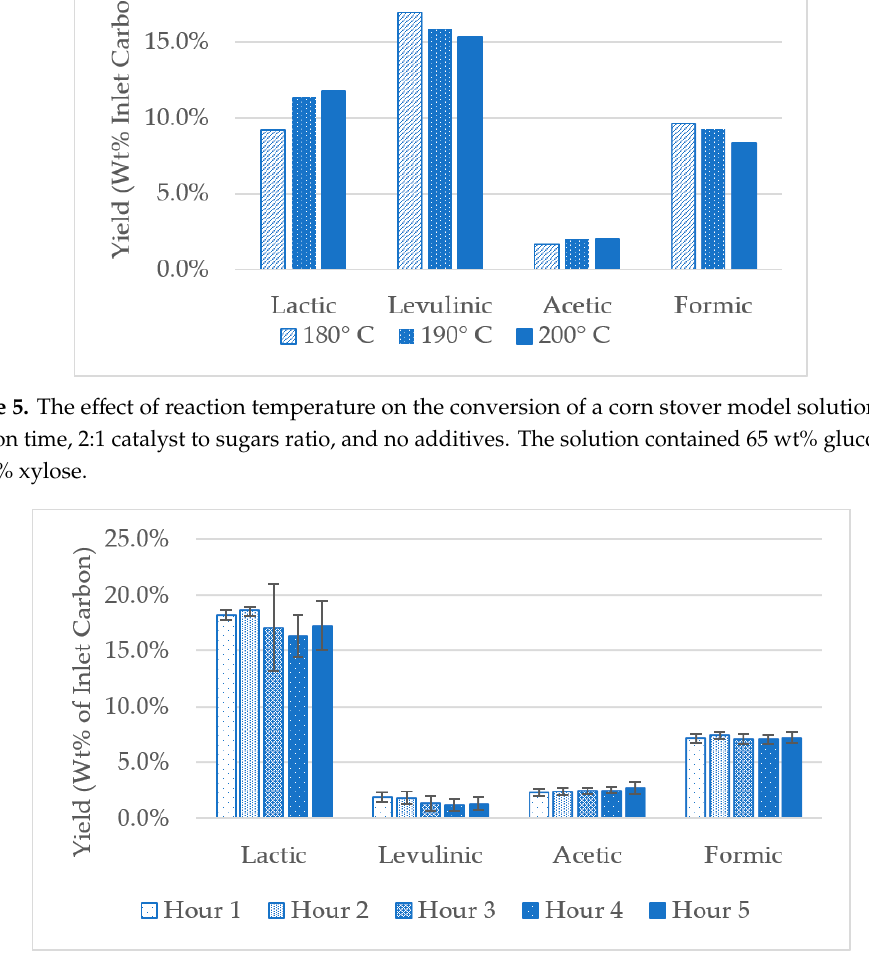
Figure 5. The effect of reaction temperature on the conversion of a corn stover model solution at 5 h reaction time, 2:1 catalyst to sugars ratio, and no additives. The solution contained 65 wt% glucose and 35 wt% xylose.